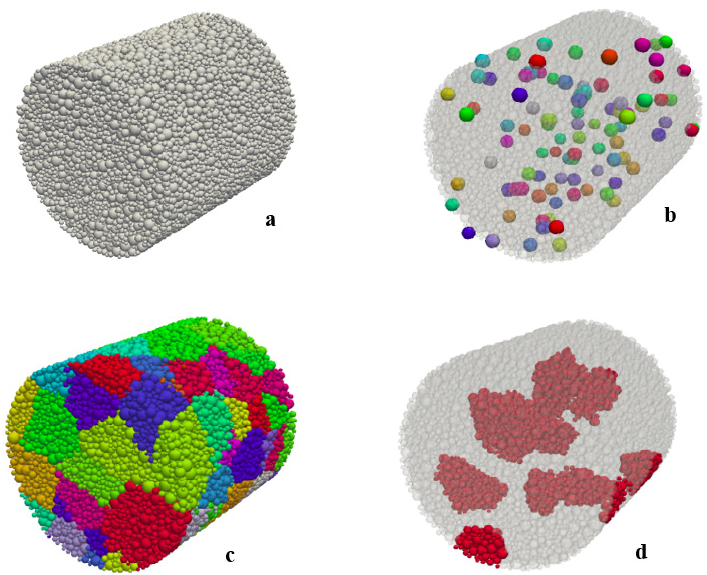
Figure 7. The four stages of creating specimens with a binary mineralogical texture. ( a ) homogeneous cylindrical specimen ( b ) homogenous specimen with seed points (coloured spheres) ( c ) DEM-spheres close to each seed points are grouped together ( d ) grouped spheres assigned to be either “valuable” (red spheres) or “gangue” (grey spheres).